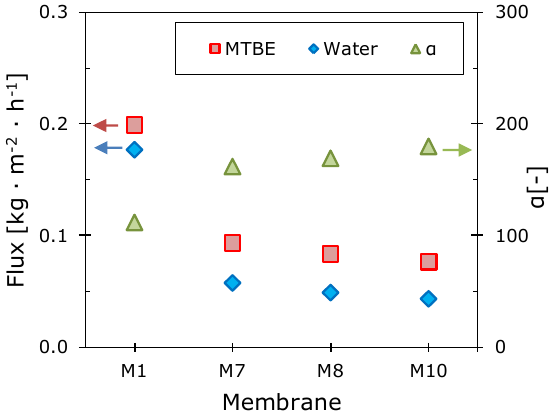
Figure 3. The dependences of the partial fluxes of MTBE and water and the MTBE/water separation factor on the side-chain length for the studied polyalkylmethylsiloxane membranes. The membrane’s thickness was 50 microns. T = 30 °C, 1% wt. MTBE in water.